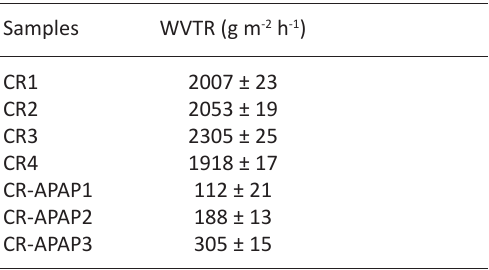
Table 2. Water Vapor Transmission Rates (WVTR) of CR hydrogels Samples